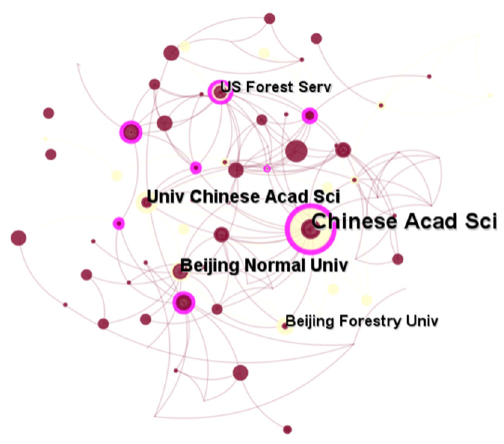
Figure 3. Institutional cooperation in research on forest ecosystem services among countries.